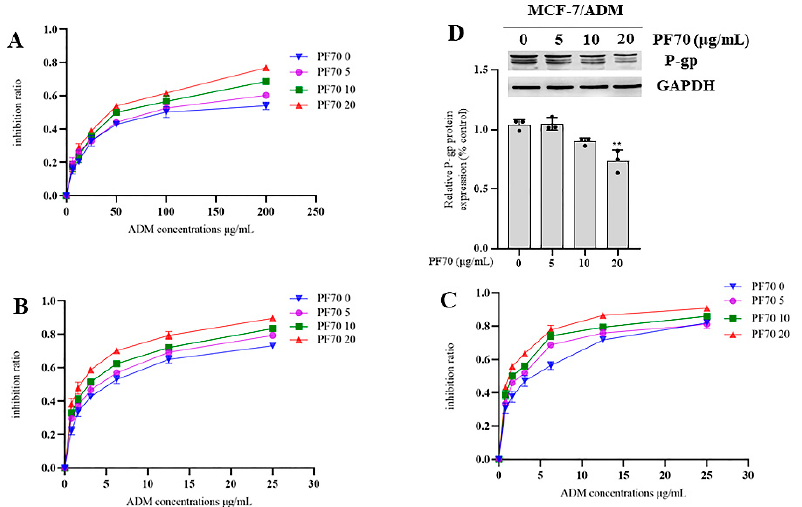
Figure 6. Inhibition ratios of ADM at different concentrations combined with compound 1 (PF70) at concentrations of 0, 5, 10 and 20 μ g/mL, respectively: ( A ) MCF-7/ADM; ( B ) K562/ADM; ( C ) A549/ADM; ( D ) Effect of 1 (PF 70) on P-gp expression. All experiments were performed in triplicate. ** p < 0.01.